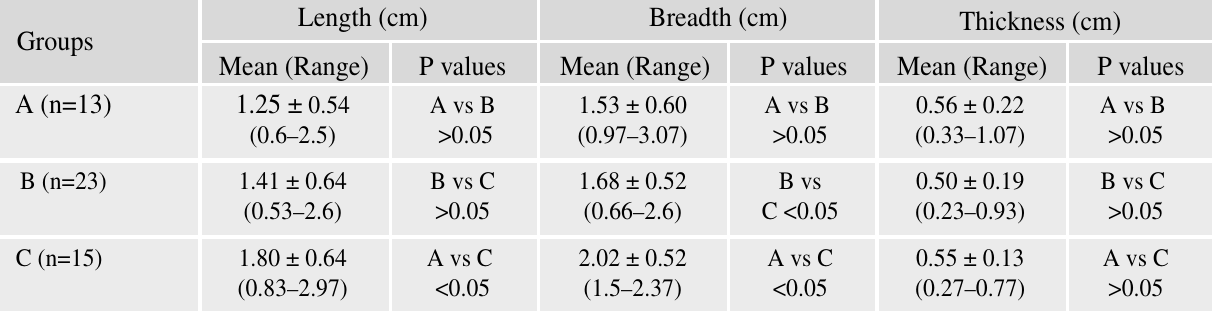
Table II: Length, breadth and thickness of isthmus of the thyroid gland in different age groups